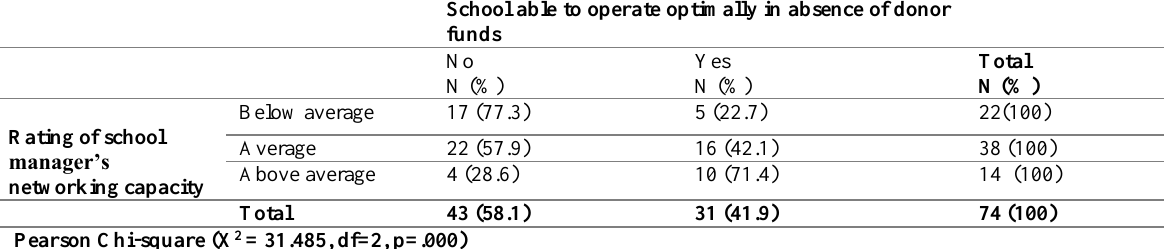
Table 10: Cross-Tabulation of Networking and Sustainability beyond Donor Funding School able to operate optimally in absence of